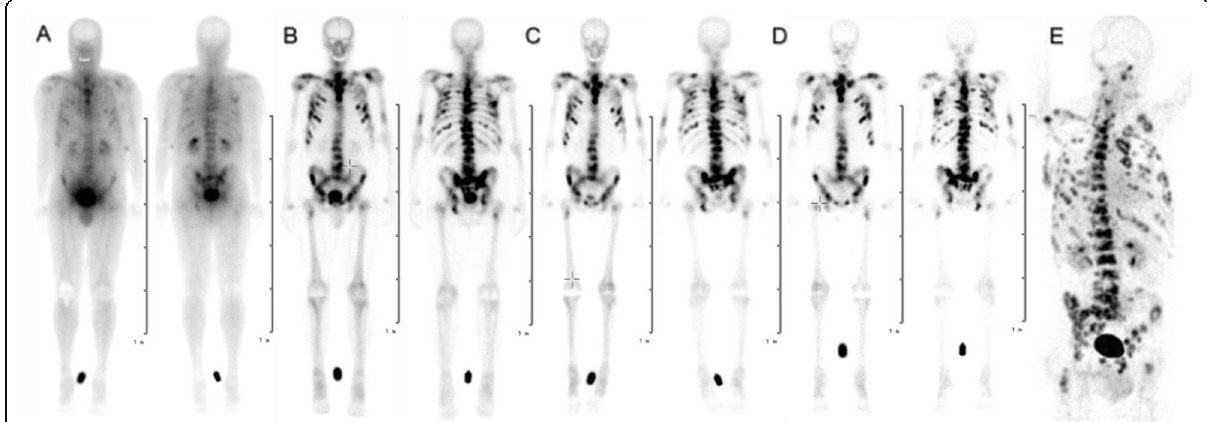
Fig. 1 Planar scintigraphy (anterior and posterior views) after therapeutic application of [ 177 Lu]Lu-DOTA ZOL at a 20 min, b 3 h, c 24 h, d 168 h, and